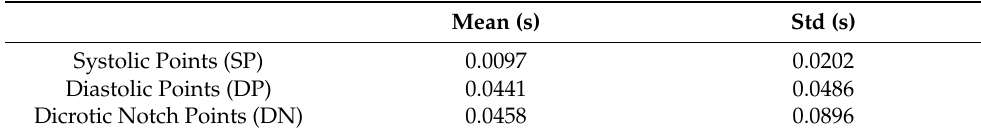
Table 1. Mean and std of errors for characteristic points.